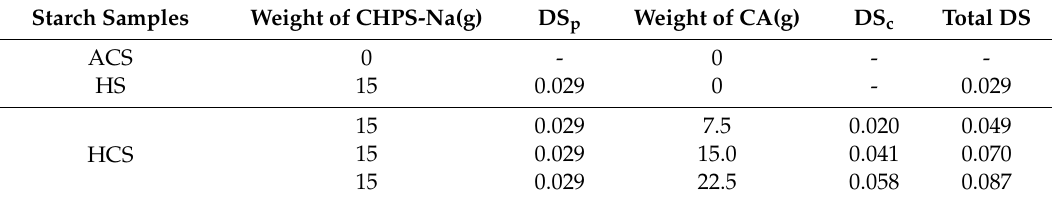
Table 1. DS of starch modification, i.e., the hydroxypropylsulfonation (DS p ) and caproylation levels Table1. DSofstarchmodification, i.e., thehydroxypropylsulfonation(DS p )andcaproylationlevels(DS c ). (DS c ).